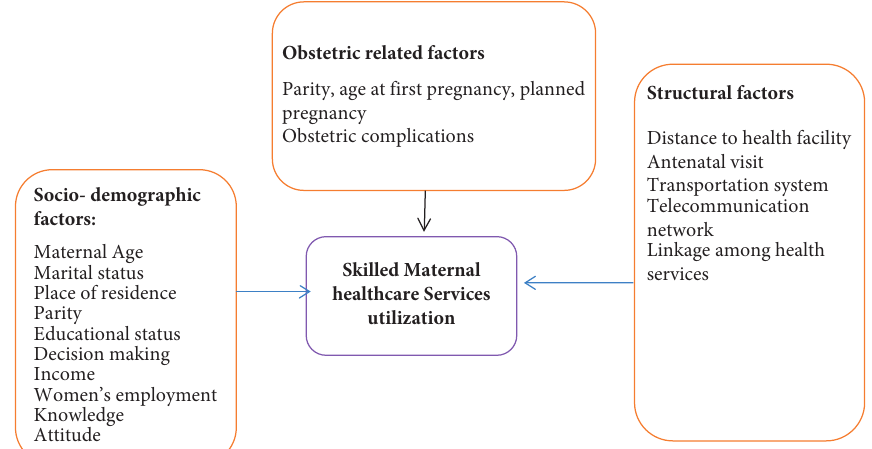
Figure 1: Conceptual framework adapted from different literature studies